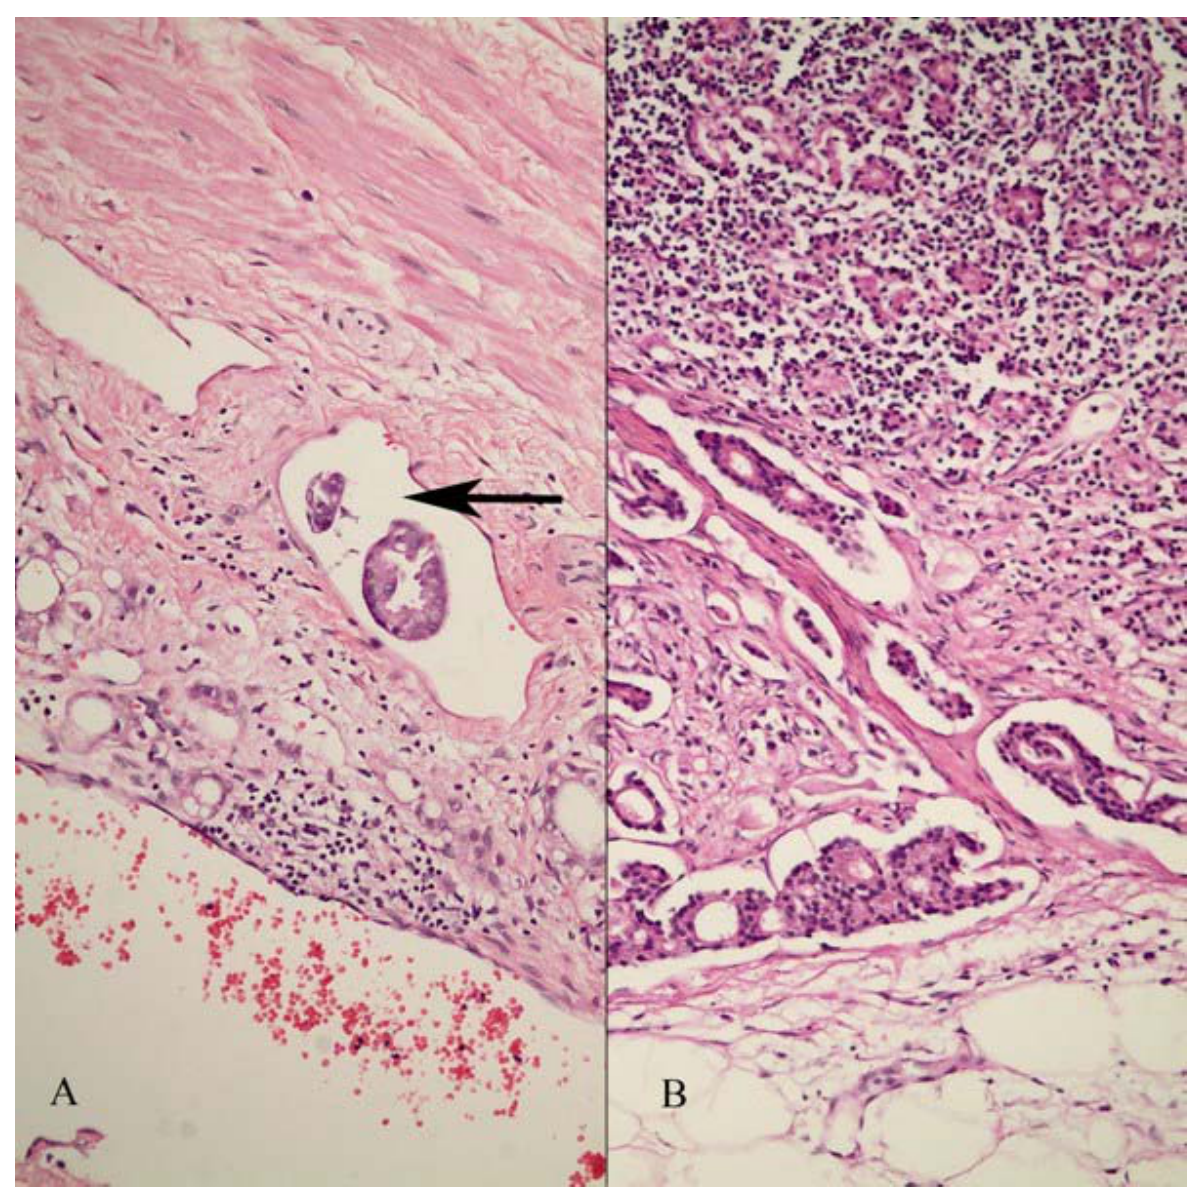
FIGURE 3. (A) LVI adjacent to a high-grade prostate carcinoma (H-E × 400). (B) Lymph node metastasis from the same tumor (H-E × 400).